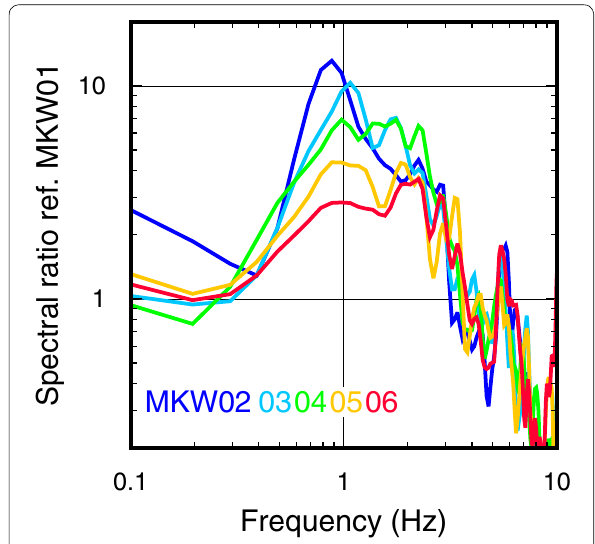
Fig. 15 Spectral ratios for the M w 3.9 earthquake (Event 2: 09 December 2018). The spectral ratios are derived from the S-wave part Fourier spectra of each station divided by the MKW01 spectra